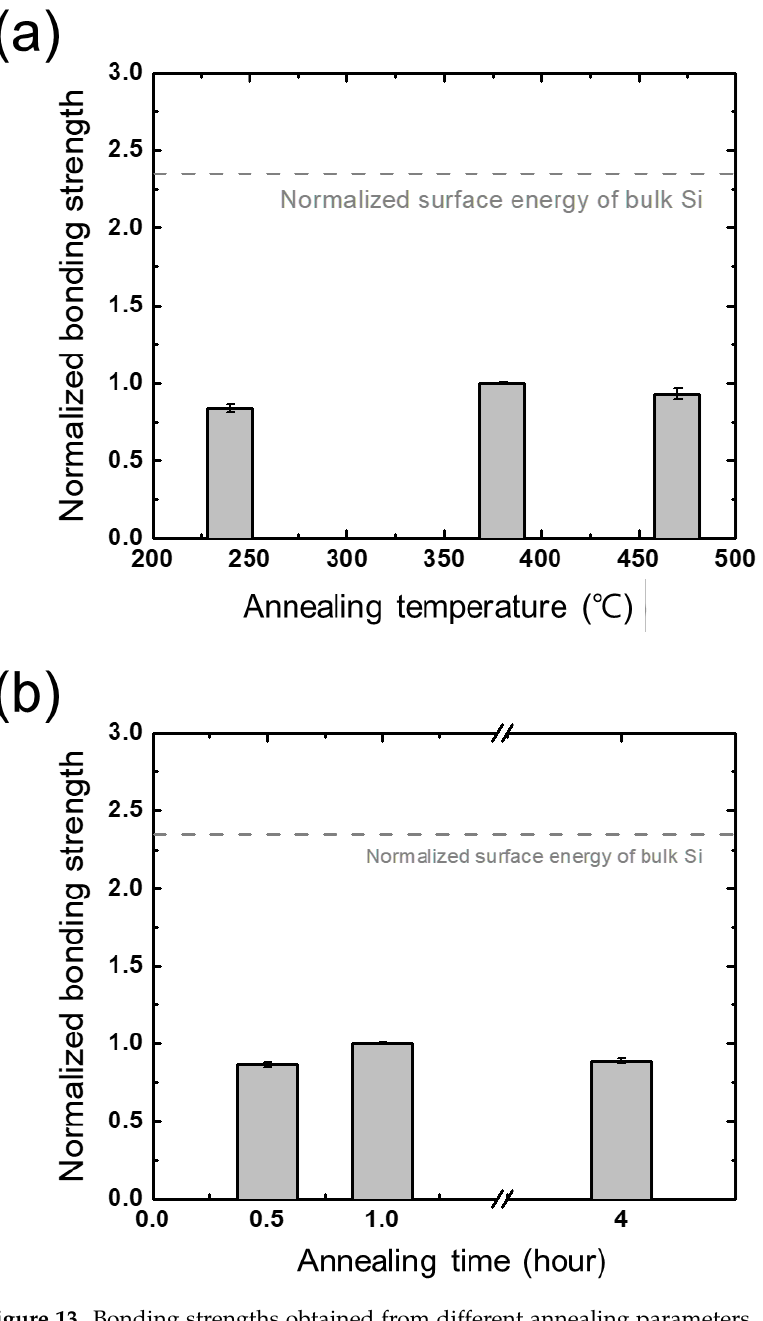
Figure 13. Bonding strengths obtained from different annealing parameters, ( a ) temperature and ( b ) time, normalized to the bonding strength with no plasma treatment.